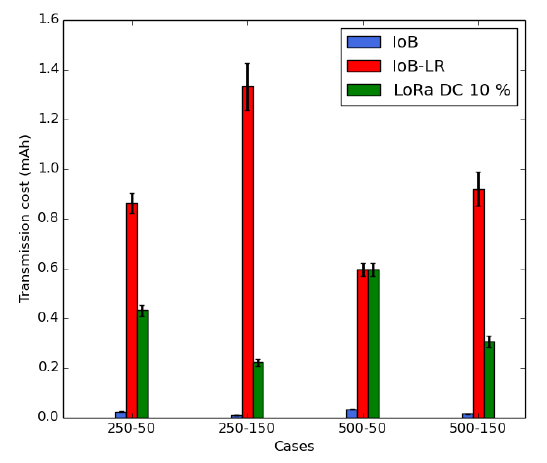
Figure 20. Average transmission cost per